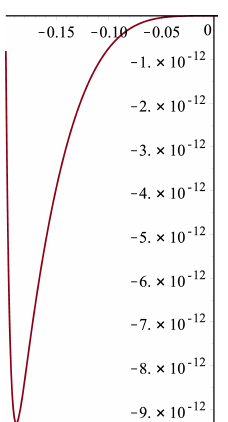
Fig. 1. The graph of the function